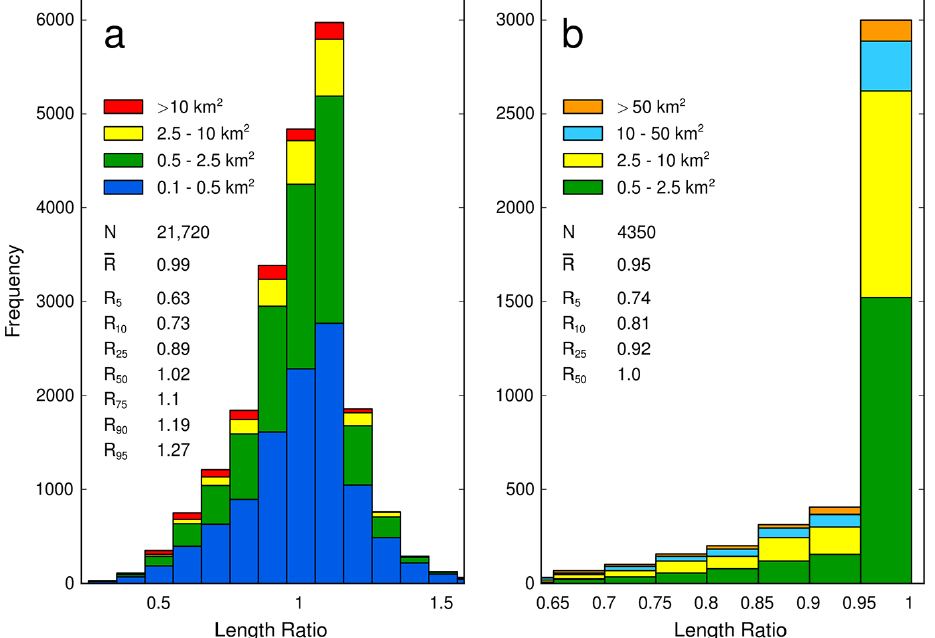
Fig. 11. Histograms illustrating the length ratio distributions of differently derived glacier lengths. Colors distinguish size categories; N indicates the total number of glaciers. Mean ( ¯ R ) and selected quantiles ( R ) are calculated for the complete distributions. Panel (a) shows the ratio of length derived from a hydrological approach to the length derived from our longest centerline. Bar width is 0.1. Panel (b) shows the ratio of length derived from the centerline between the highest and the lowest glacier elevation to the length derived from our longest centerline. Only glaciers with more than one centerline are considered. Bar width is